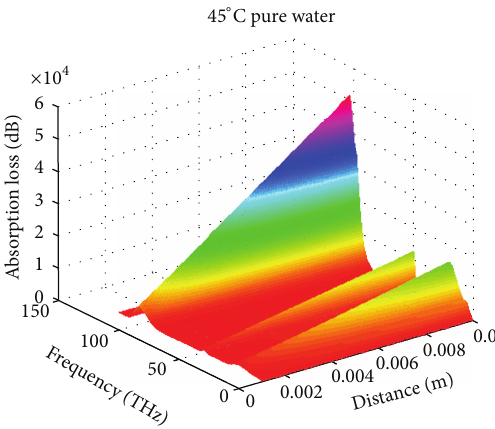
Figure 2: Absorption loss of pure water at 1mm to 10mm distance between 0.1 and 120THz.